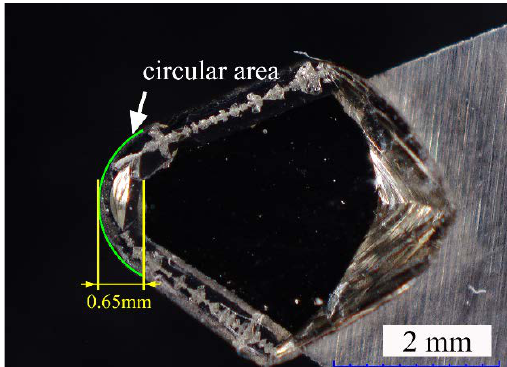
Figure 8. Illustration of the generated cross-sectional profile at different depths of the cut, where the cross-sectional profile under two conditions are the same when the depth of the cut is smaller than the height of the circular area of the diamond tool.